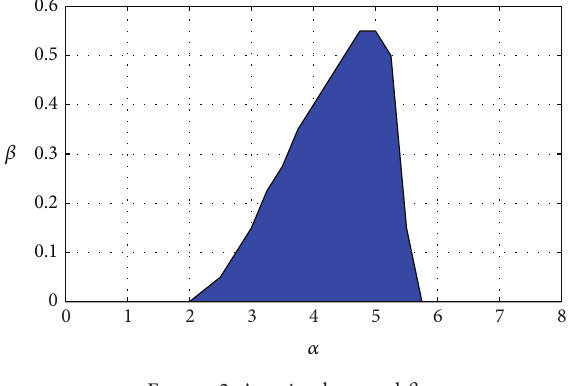
Figure 2: A region by 𝛼 and 𝛽 .